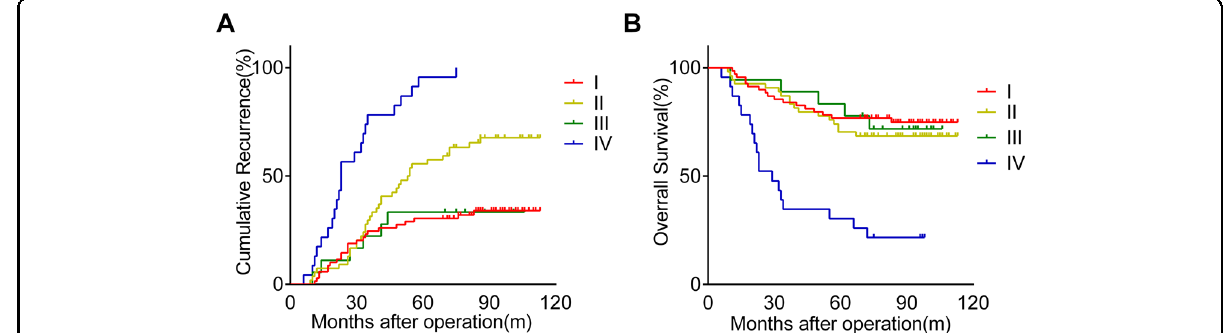
Fig. 5 Kaplan – Meier curves of recurrence and survival among glioma patients. A , B Glioma patients with both high ANXA2 and GPC1 expression had the poorest prognoses as measured by cumulative recurrence and overall survival. A Kaplan – Meier analyses of cumulative recurrence in glioma patients. P (I vs. IV) < 0.001; P (II vs. IV) < 0.001; P (III vs. IV) < 0.001; P (I vs. II) < 0.01; P (III vs. II) < 0.05. B Kaplan – Meier analyses of overall survival in glioma patients. P (I vs. IV) < 0.001; P (II vs. IV) < 0.001; P (III vs. IV) < 0.01. I, ANXA2 low /GPC1 low ; II, ANXA2 low /GPC1 high III, ANXA2 high /GPC1 low ; and IV, ANXA2 high /GPC1 high